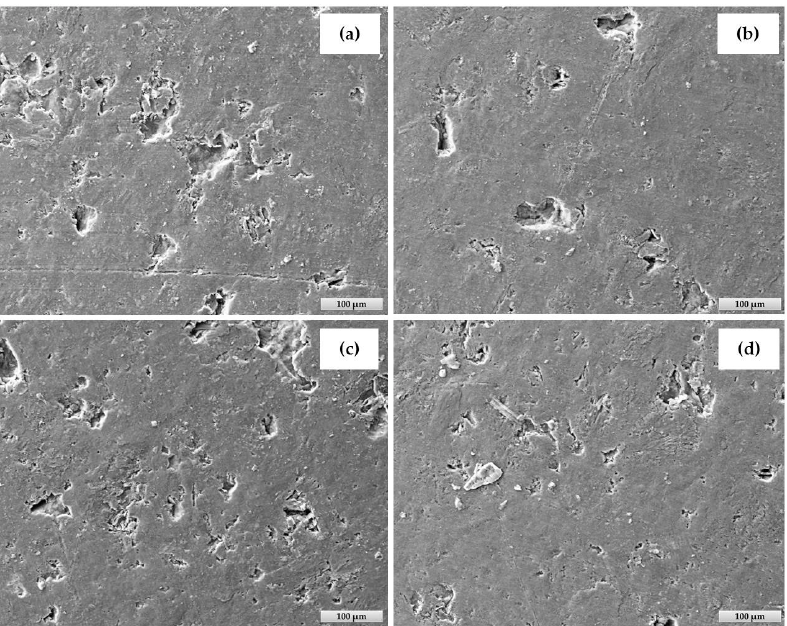
Figure 10. SEM images of BPP ( a ) after aging, and after potentiostatic measurements at ( b ) OCP, ( c ) 0.1 V, and ( d ) 0.8